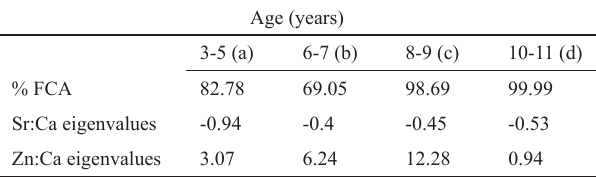
Table 4. Variability explained by the first canonical axis (% FCA) and eigenvalues from the discriminant analysis of otolith microchemistry (Figure 4, a-d). Letters in brackets indicate the reference to Fig. 4